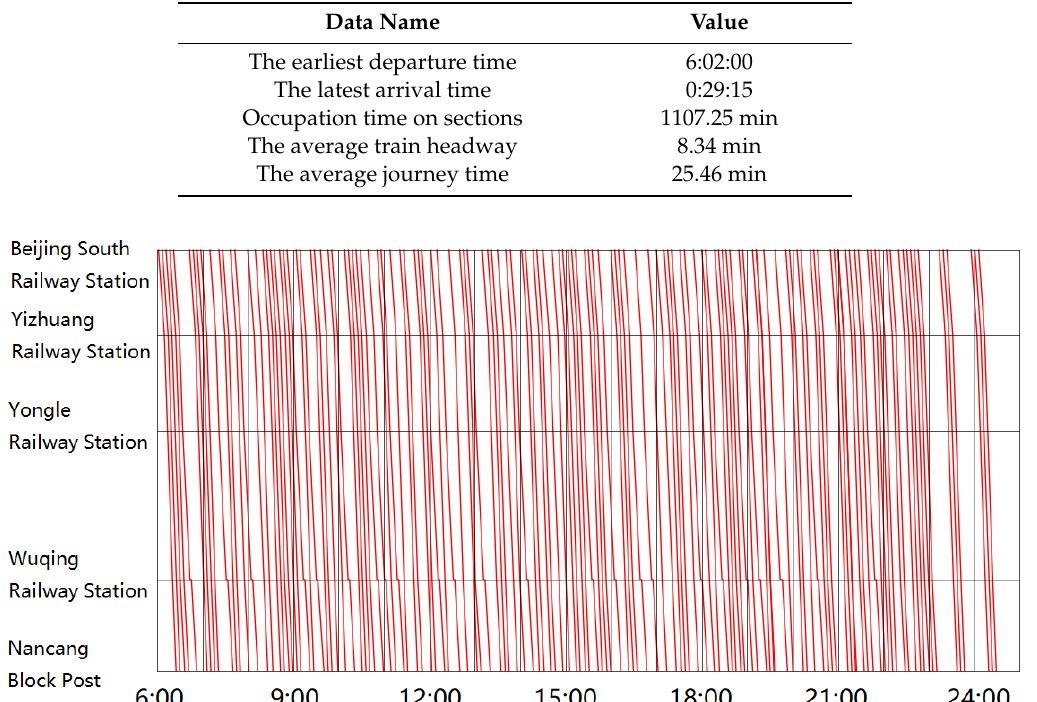
Figure 8. An original timetable of the Beijing – Tianjin Intercity Railway.